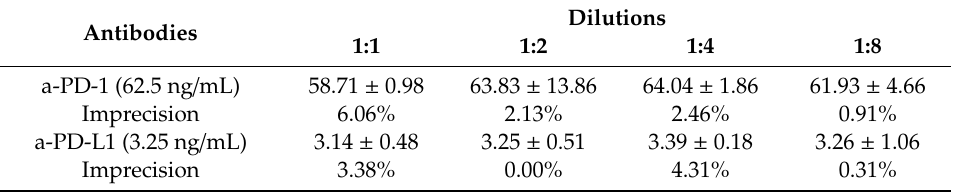
Table 4. Impact on the accuracy and imprecision of the dilution of highest antibody concentrations. Dilutions Antibodies 1:1